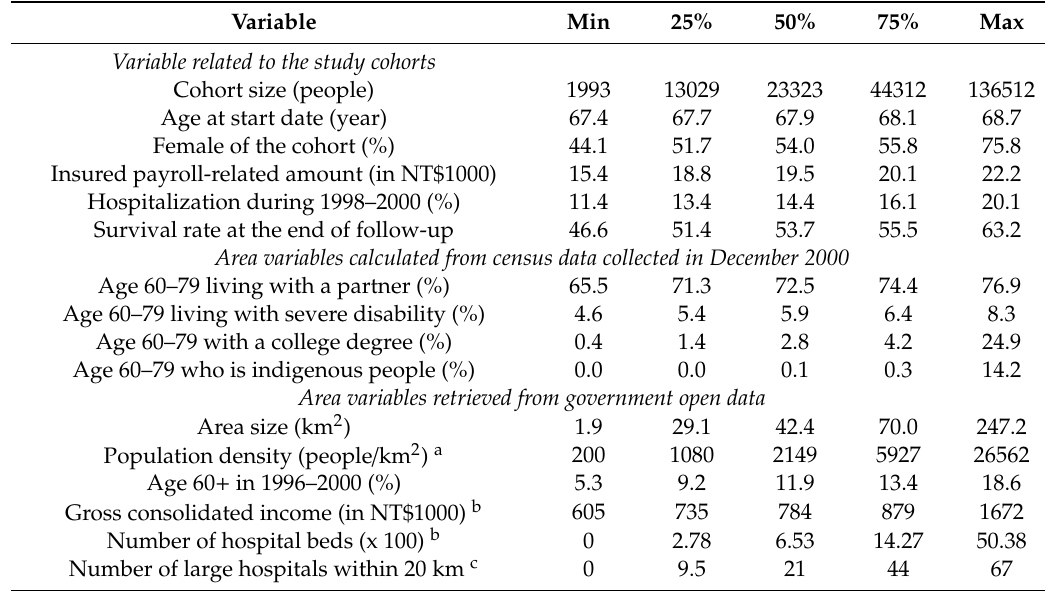
Table 1. Summary characteristics of the 63 study areas and corresponding cohorts. Variable Min